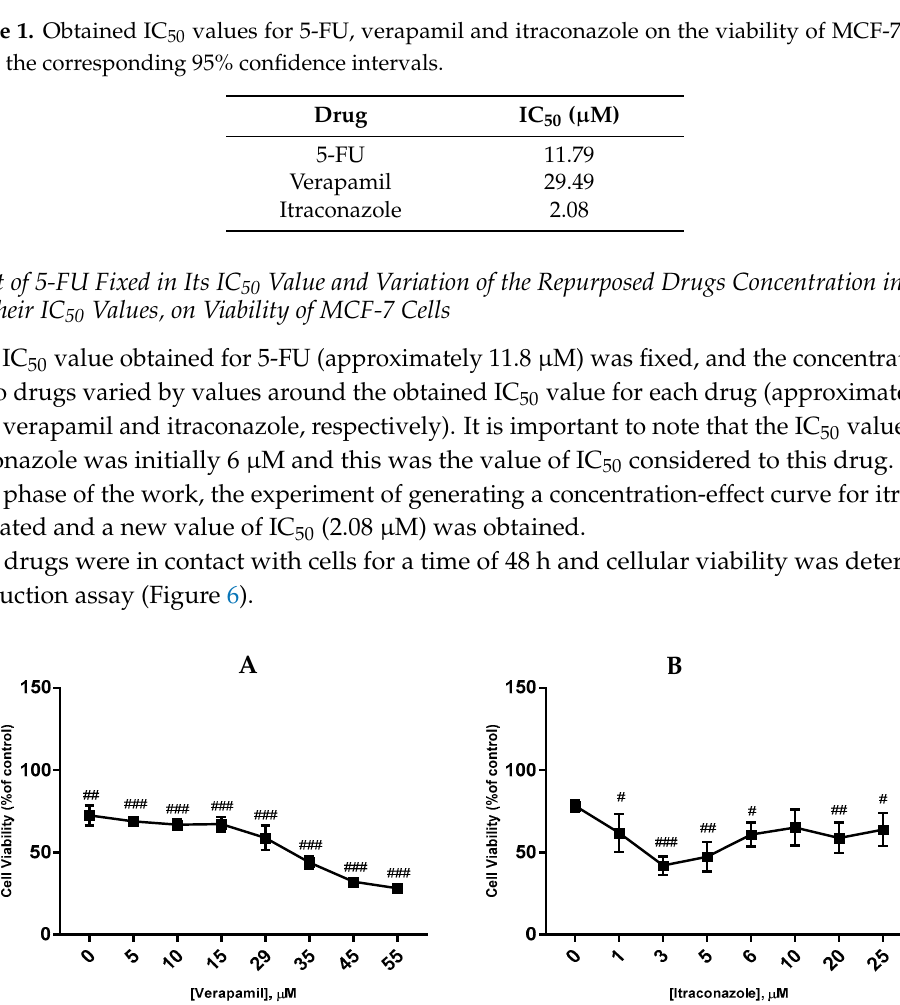
Figure 6. Effect of verapamil ( A ) and itraconazole ( B ) combined with 5-FU on the viability of MCF-7 cells. Each drug and drug combination were added in fresh medium, in sextaplicates. Results are presented as mean ± SEM, and represent the viability of cells (% of control) of three independent experiments. ### p < 0.001, ## p < 0.01 and # p < 0.05 vs. control.